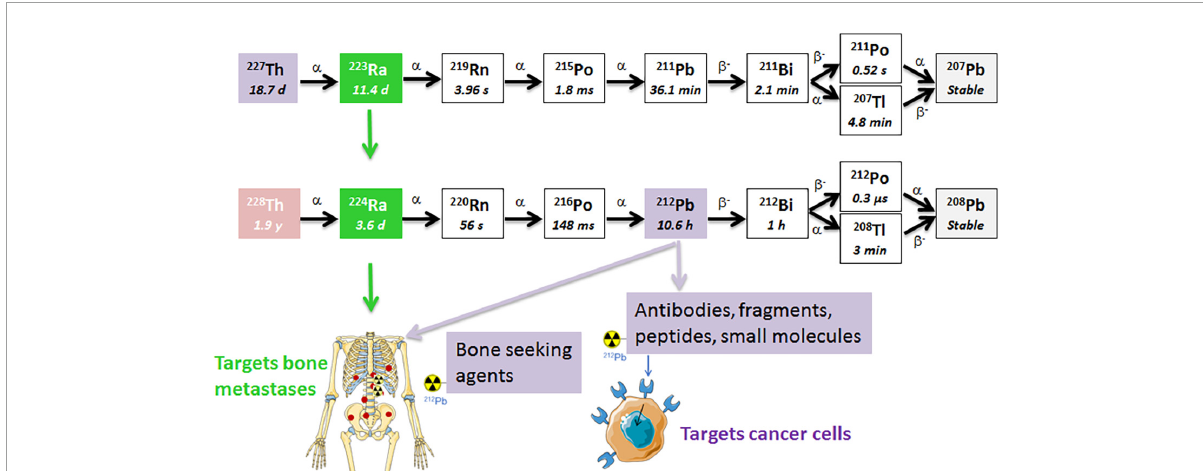
FIGURE1 The decay chains of 227 Th and 228 Th. The radium isotopes are chemically similar to calcium and are natural bone-seekers, and thus, will target osteoblastic bone metastases. The progeny 212 Pb in the 224 Ra decay chain has a suitable half-life for chelation by a tumor-specific ligand/mAb that targets cancer cells (41, 54, 55). The short half-life of progeny 211 Pb in the 223 Ra decay chain is not practical for conjugation to a targeting ligand since the majority of the decay will occur before the ligand reaches the tumor sites. α , alpha particle; β , beta particle.